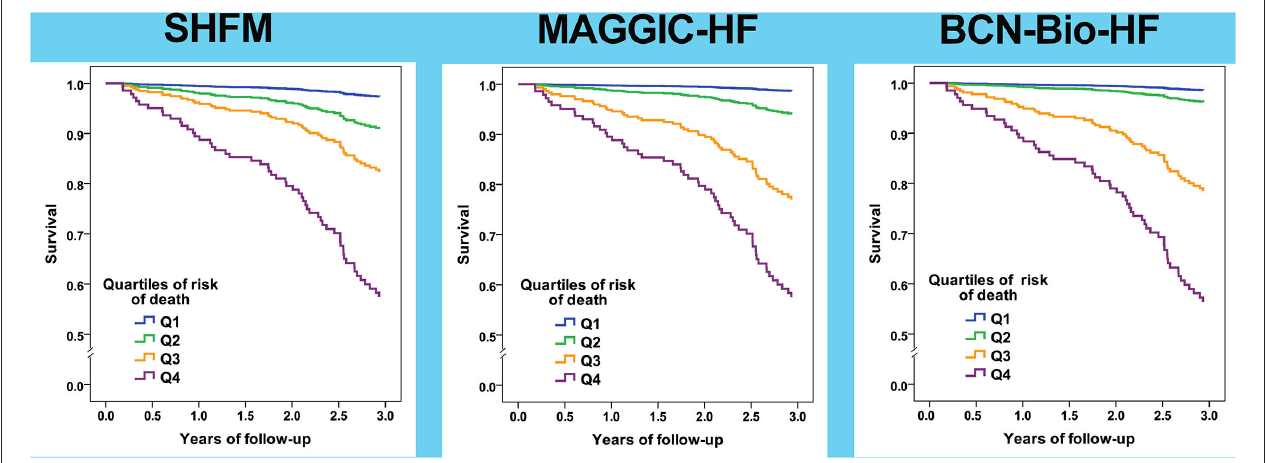
FIGURE 4 | Survival curves based on quartiles of risk of all-cause death for the three calculators based on risk estimated after 12 months of follow-up.